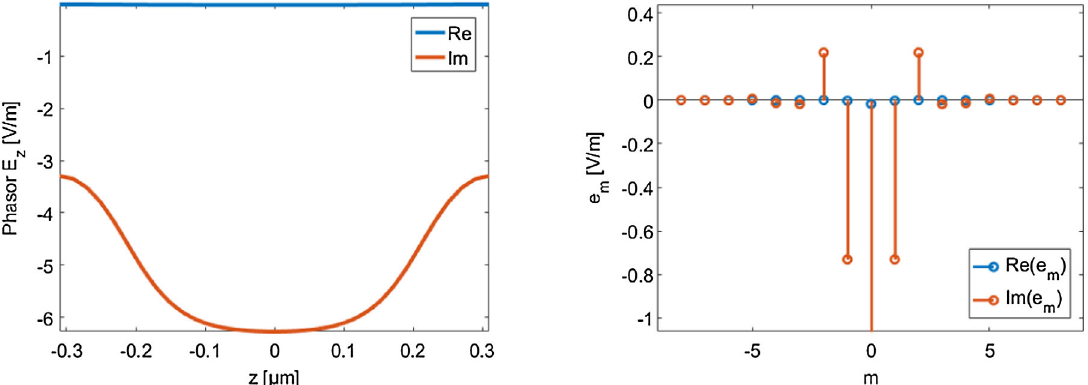
FIG. 4. Longitudinal electric field on the beam axis for the Bragg mirror structure in Fig. 3 and spatial Fourier harmonics for incident laser field normalized to 1 V =